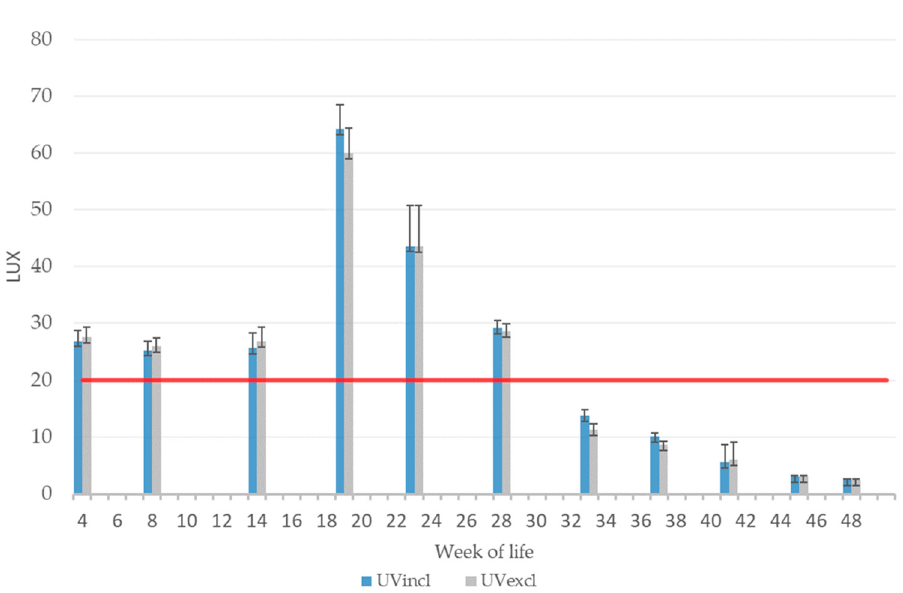
Figure 3. Mean light intensity (lux) during rearing and production with (UVincl) and without (UVexcl) additional UV-A light (red line: European recommendation of the minimum light intensity in laying hen houses).